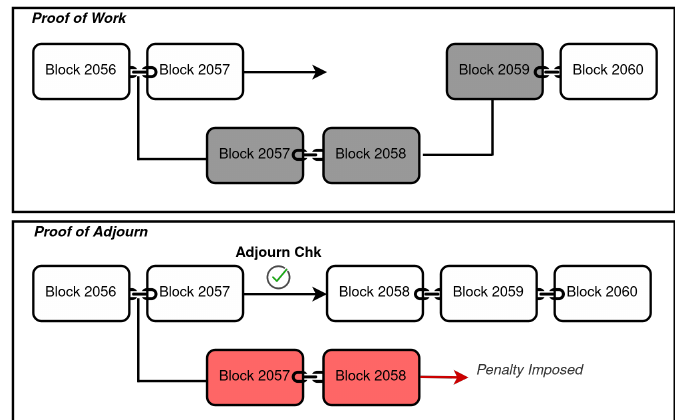
Figure 10. The top chain shows a selfish miner attacker in PoW where legitimate blocks are discarded (2057). The chain at the bottom is PoAj where the attack is